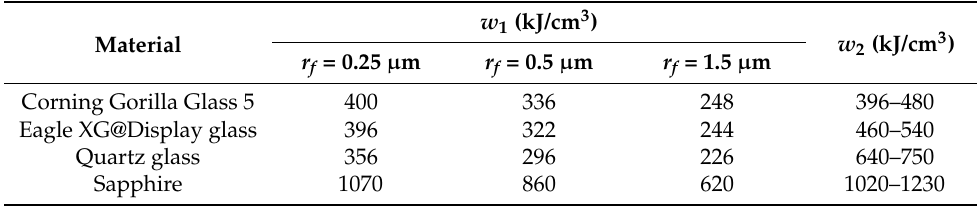
Table 1. VED bounds w 1 and w 2 calculated from (13,15) for β max = 0.12 and several materials at different filament radii r f for K tw ≈